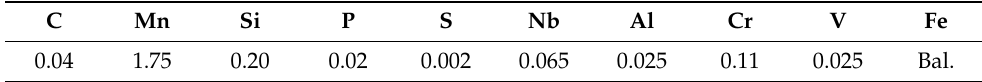
Table 1. Chemical composition of the API 5L X80 steel plate